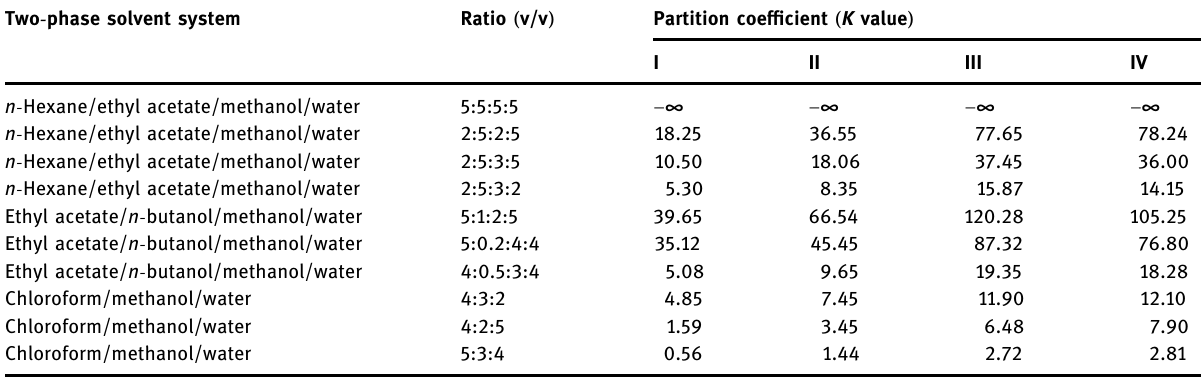
Table 5: The K values of the target compounds in di ff erent solvent systems Two - phase solvent system Ratio ( v/v )